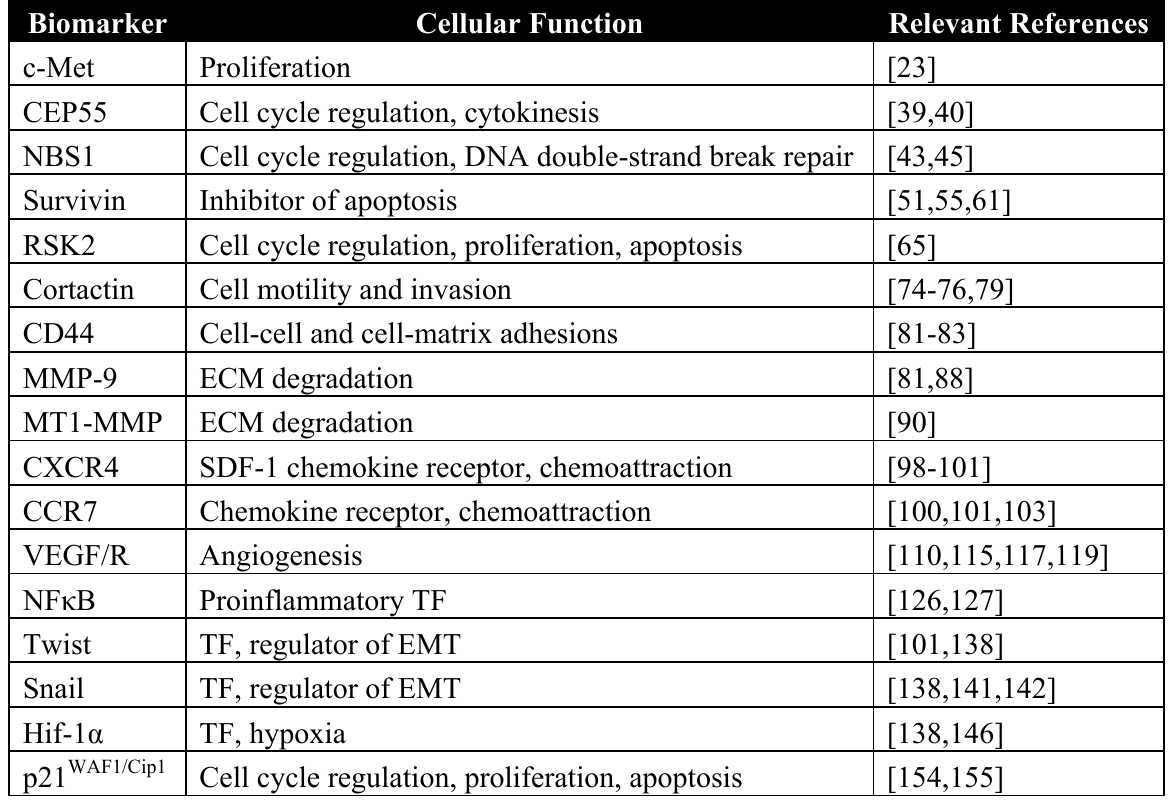
Table 1. Recently identified biomarkers involved in lymph node